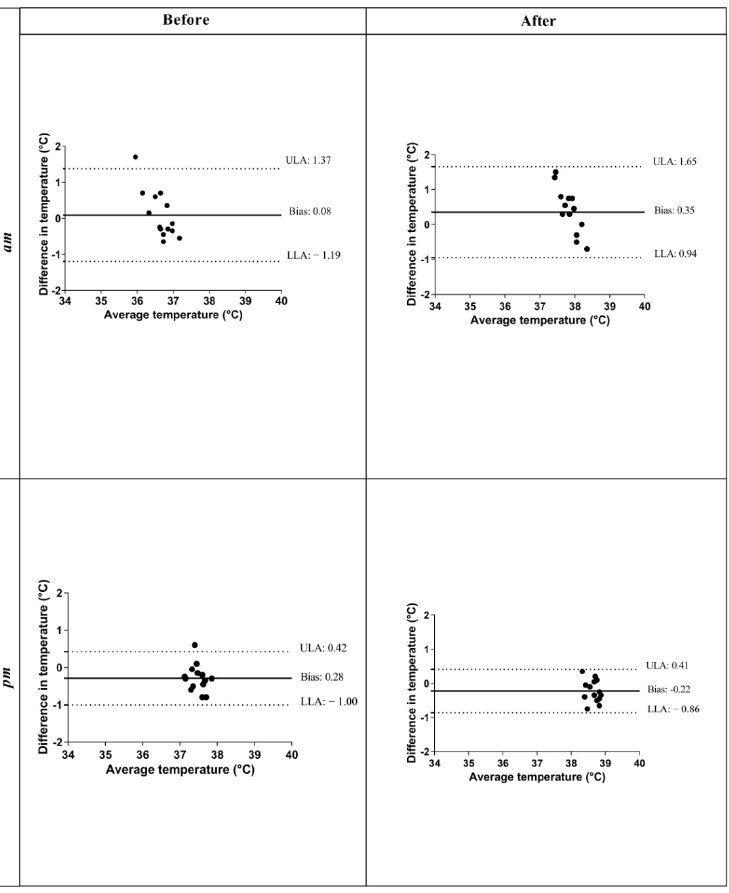
Figure 2. Bland–Altman plots of ocular temperature and rectal temperature, measured during a.m. hours before and after exercise, and during p.m. hours before and after the exercise. Average temperatures were plotted against differences with temperatures. Dotted lines represent upper and lower limits of agreement (ULAs and LLAs). The solid black line represents the mean difference or the bias.